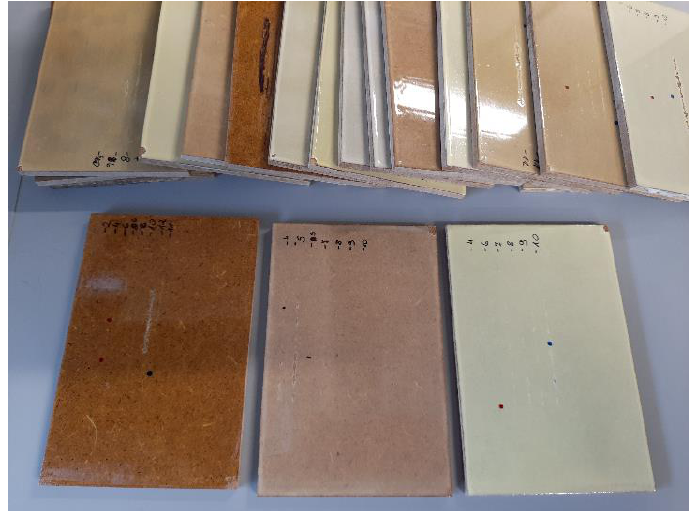
Figure 2. Photograph of unfilled varnish coatings and varnish coatings containing: 5 wt.% Alu C and 5 wt.% Sialon (from left to right).